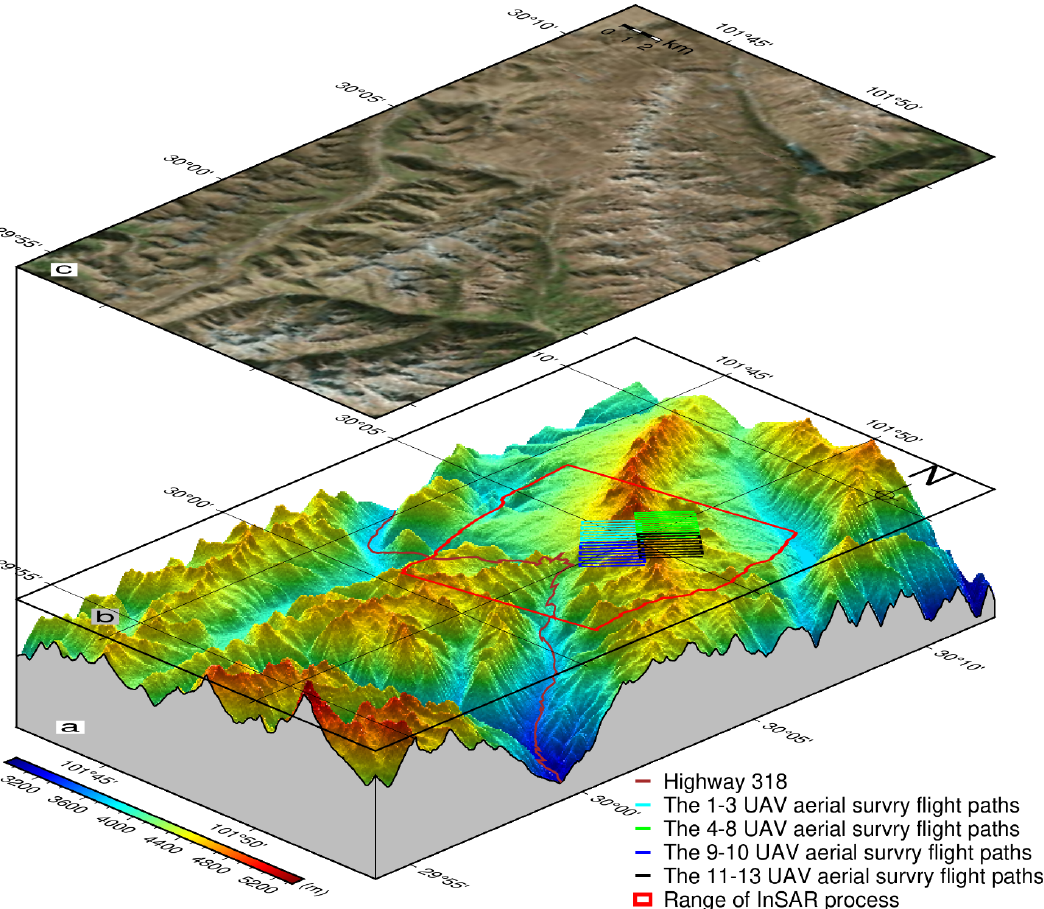
Figure 2. Enlarged view of the study area: ( a ) a three-dimensional topographic view of the survey area based on the AOLS PALSAR DEM (12.5 m); ( b ) the InSAR processing area (polygon marked red) and the flight paths corresponding to the four subareas (the cyan, green, blue, and black lines represent block one, two, three, and four, respectively); and ( c ) the ground surface cover based on Google Map satellite images of the study area. All maps are at the 135/25 (azimuth/angle of pitch) view, differing in